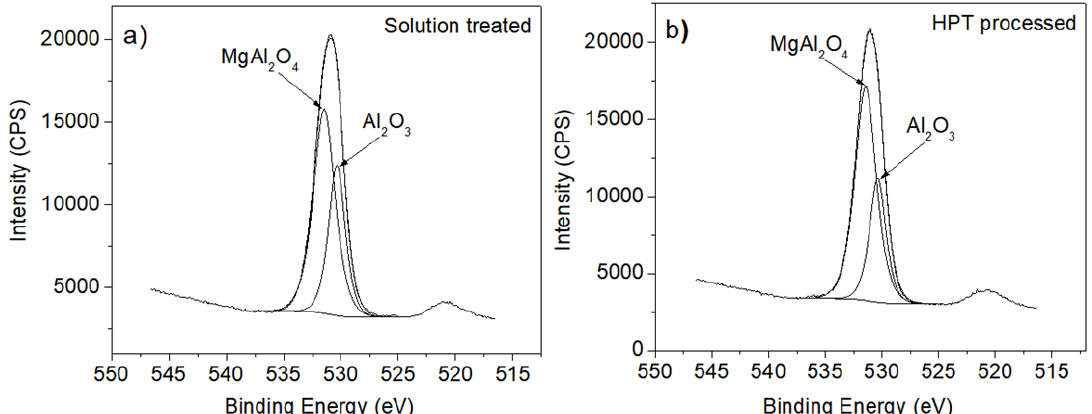
Figure 8. The high resolution spectrum in the oxygen energy range (O1s) for (a) the solution treated and (b) the HPT-processed alloy.